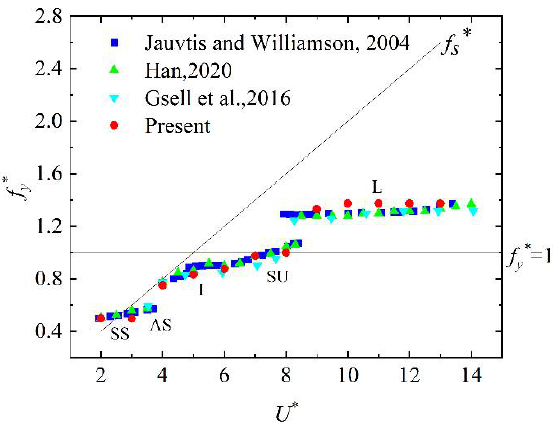
Figure 10. Transverse vibration frequency versus reduced velocity [22,24,25].